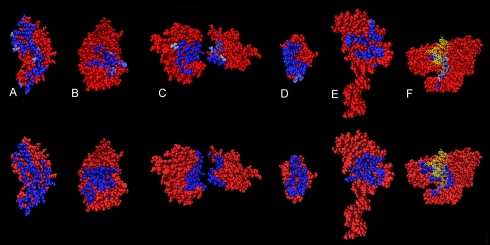
iJET predictions on several types of interfaces.Structures: allophycocyanin 1all:B (A), phosphotransferase 1apm:E (B),
human CDC42 gene regulation protein 1grn:AB (C), oncogene protein 1ycr
(D), signal transduction protein 1shc (E), large fragment of
Thermus aquaticus DNA polymerase I 2ktq (with the
DNA chain in yellow) (F). Top: iJET predictions with residues occurring
at least 7 times out of 10 runs highlighted using a blue scale. Dark
blue corresponds to 10 runs (the majority of residues in the figure).
Bottom: experimental interaction sites.